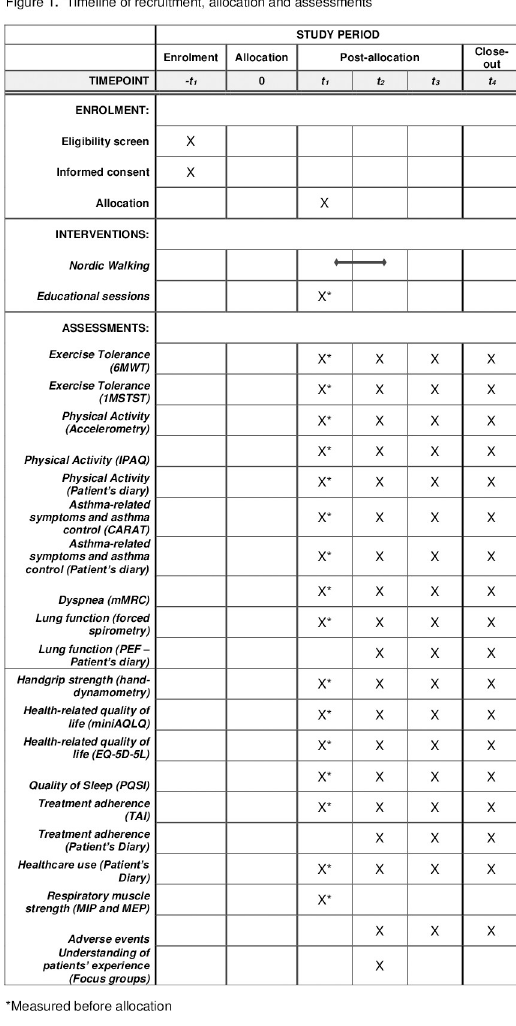
Fig 1. Timeline of recruitment, allocation and assessments. � Measured before